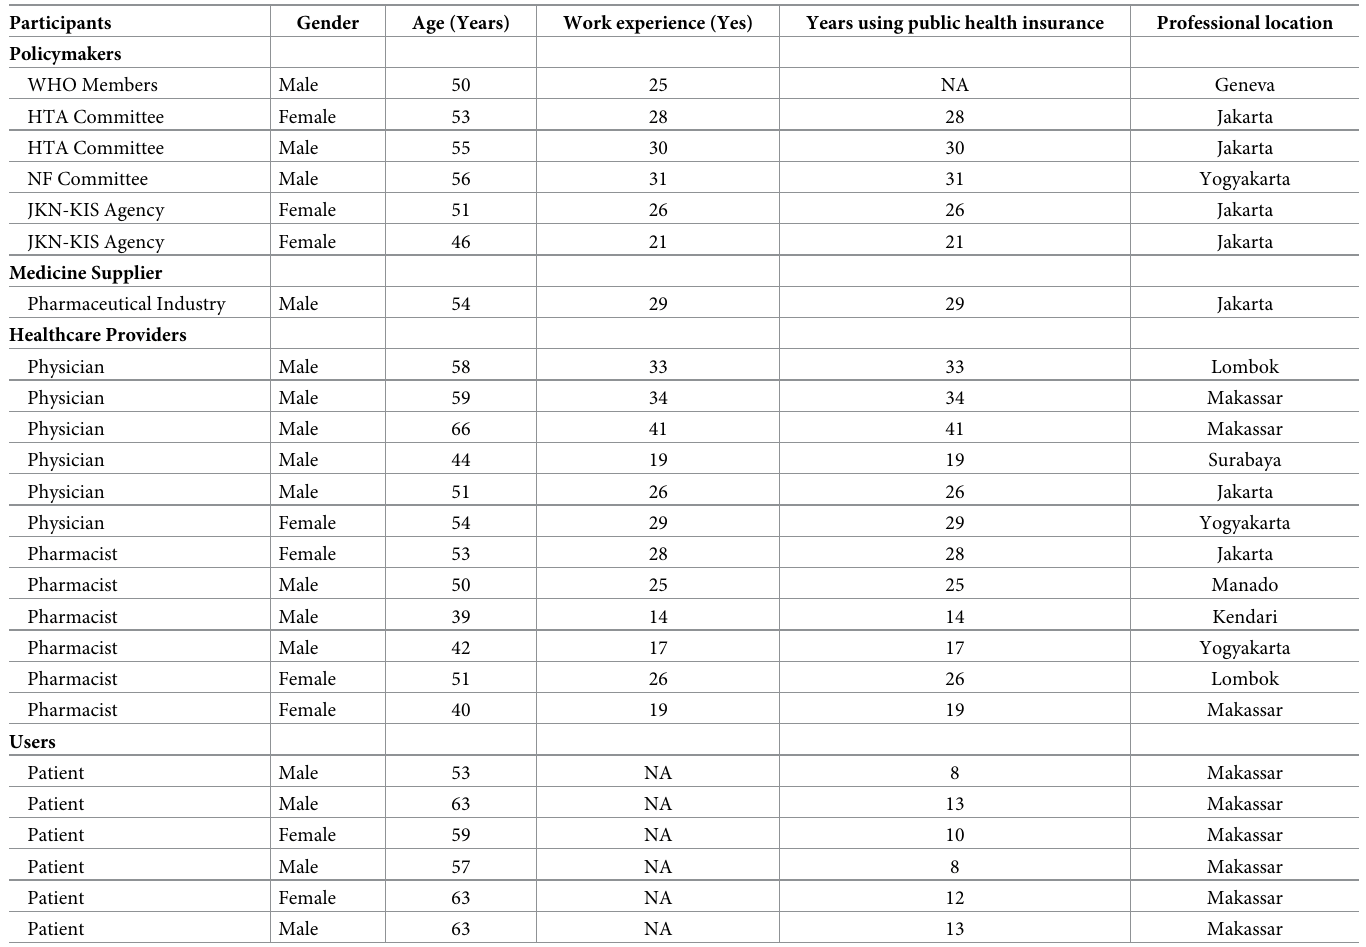
Table 2. Classification of participants